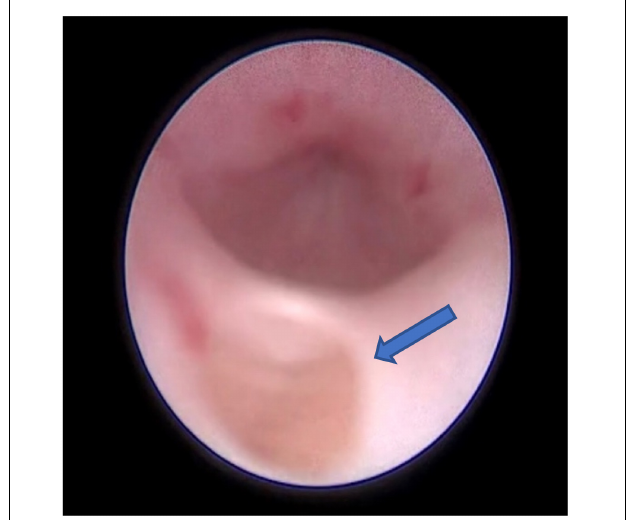
FIGURE 3 | The voiding cystourethrogram showed the obstruction and the proximal dilation of the urethra without vesicoureteral reflux, and a large amount of residual contrast solution in the bladder after voiding. The arrow points to the circular defect of the anterior urethra.